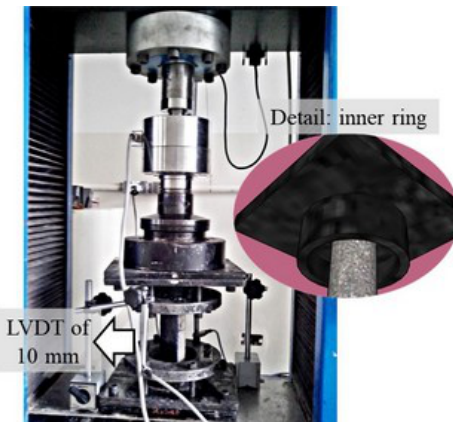
Figure 5. Apparatus with internal diameter of 50 mm for conducting direct tensile